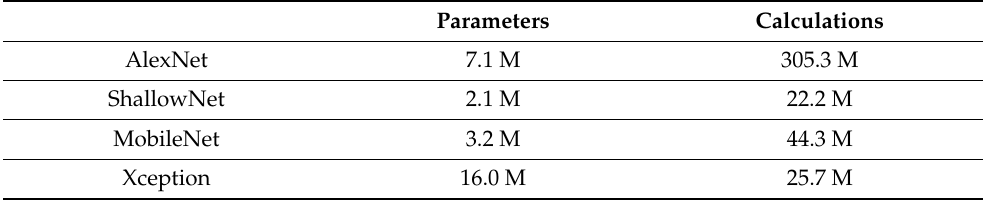
Table 1. Number of parameters and calculations in each